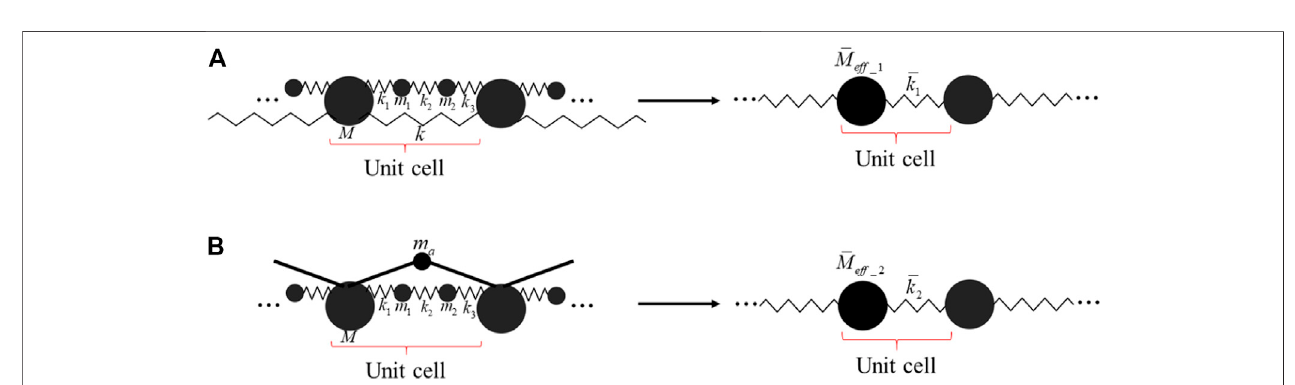
Frontiers in Materials |